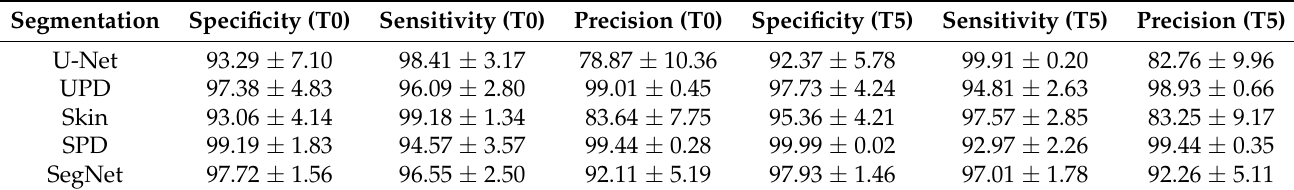
Table 5. Specificity and sensitivity provided by the STAPLE algorithm for the implemented approaches. Values are expressed in percentages at each time point, T0 and